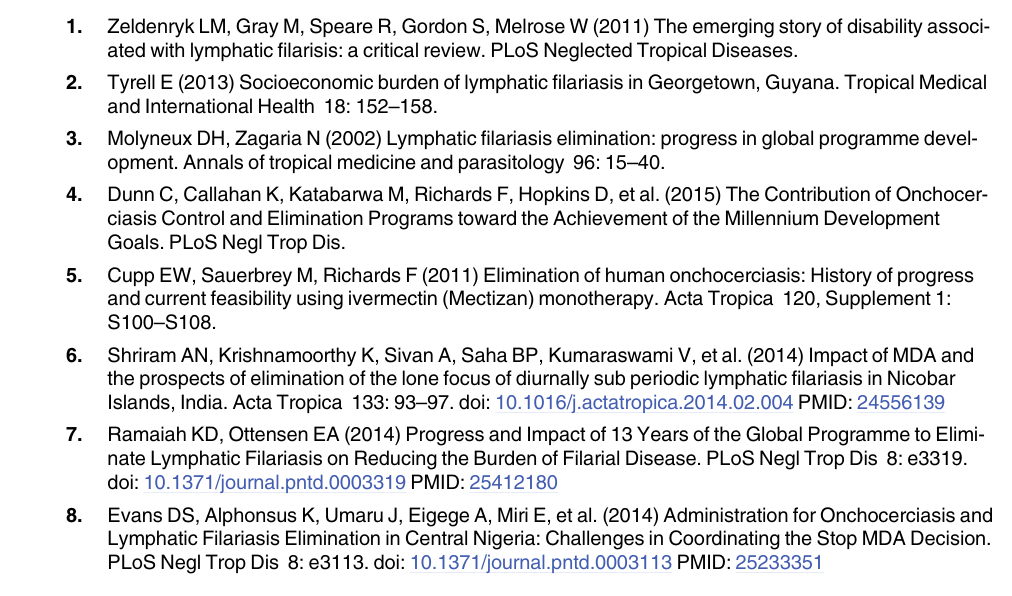
ered from the peritoneal cavity of Brugia malayi infected jirds four weeks post-transplanta- tion. Numbers are averages of counts from homogenates of a minimum of six female worms per